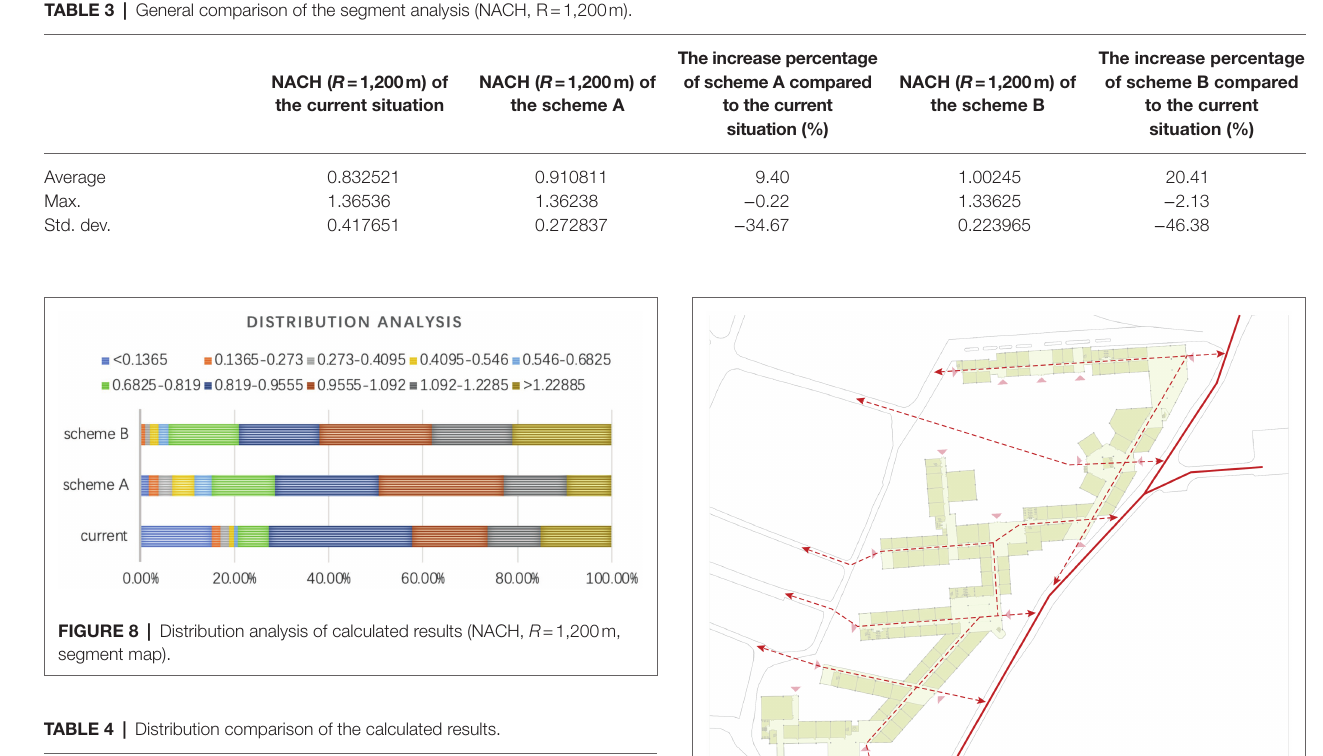
Percentage of segments amount of the current situation (%)